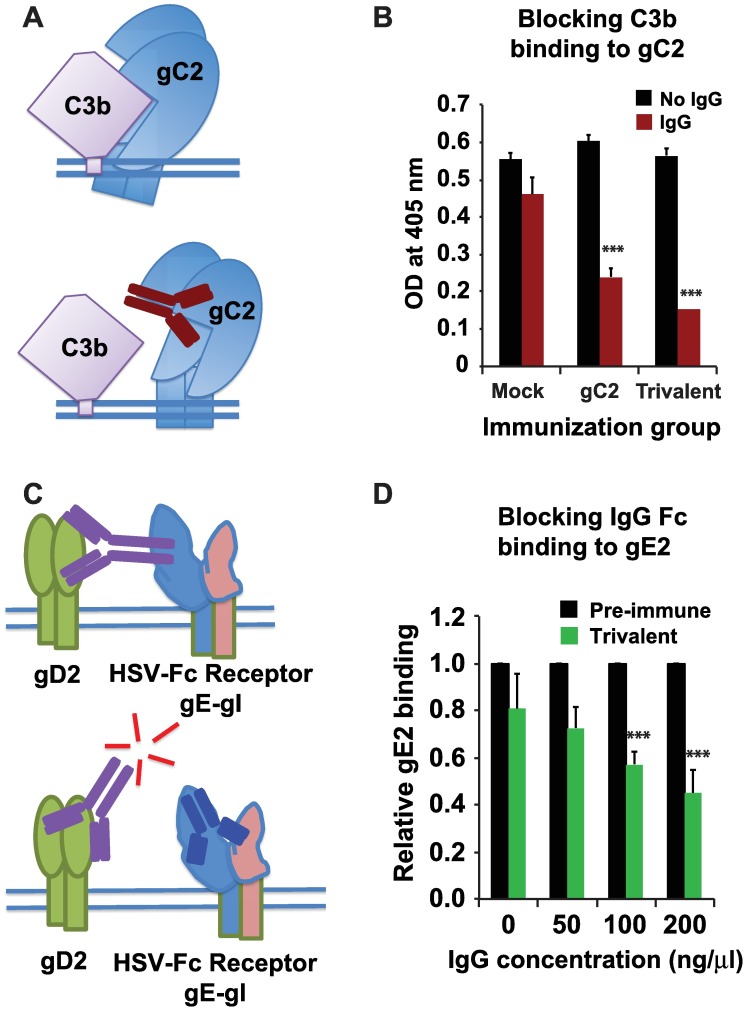
Antibodies that block immune evasion activities.(A) Top model: gC2 is a complement regulatory molecule. Activation of complement leads to deposition of complement component C3b on the virus or infected cell surface where gC2 binds to C3b and blocks downstream complement activation [31]. Bottom model: Antibody produced by immunization with gC2 binds and blocks its interaction with C3b, enabling downstream activation of complement [16]. (B) Blocking immune evasion domains on gC2. IgG obtained at week 12 after the third immunization of animals in the mock, gC2, or trivalent group was incubated with gC2 protein and added to C3b-coated wells. Results represent the mean + SEM of 2 IgG samples per group run 3 times. (C) Top model: gE2 is an IgG Fc binding molecule: An antibody produced by immunization with gD2 binds by its F(ab’)2 domain to gD2 and by its Fc domain to gE2 that forms an IgG Fc receptor complex with glycoprotein I (gI2) [25]. Bottom model: antibody to gE2 produced by immunization binds and blocks its ability to interact with the Fc domain of antibody to gD2, enabling the Fc domain to activate complement and mediate antibody dependent cellular cytotoxicity [29, 32]. (D) Blocking immune evasion domains on gE2. IgG obtained prior to the first immunization or at week 40 after the fourth immunization in the trivalent group was incubated with gE2 and then added to wells coated with nonimmune human IgG. Results are expressed relative to the binding of gE2 when incubated with IgG obtained prior to the first immunization. The results represent the mean + SEM of one pre-immune IgG and two immune IgG samples tested three times. P values for (B) and (D) were calculated using mixed effects models as described in the legend to Fig 2E. *** indicates P<0.001.